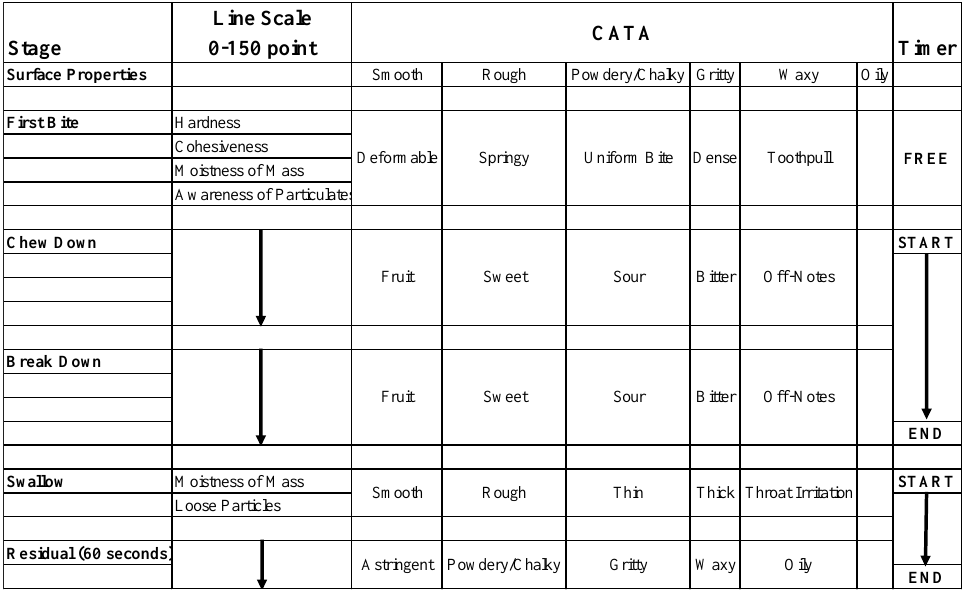
Figure 1. Multiple-attribute time-intensity (MATI) descriptive panel scorecard. CATA,